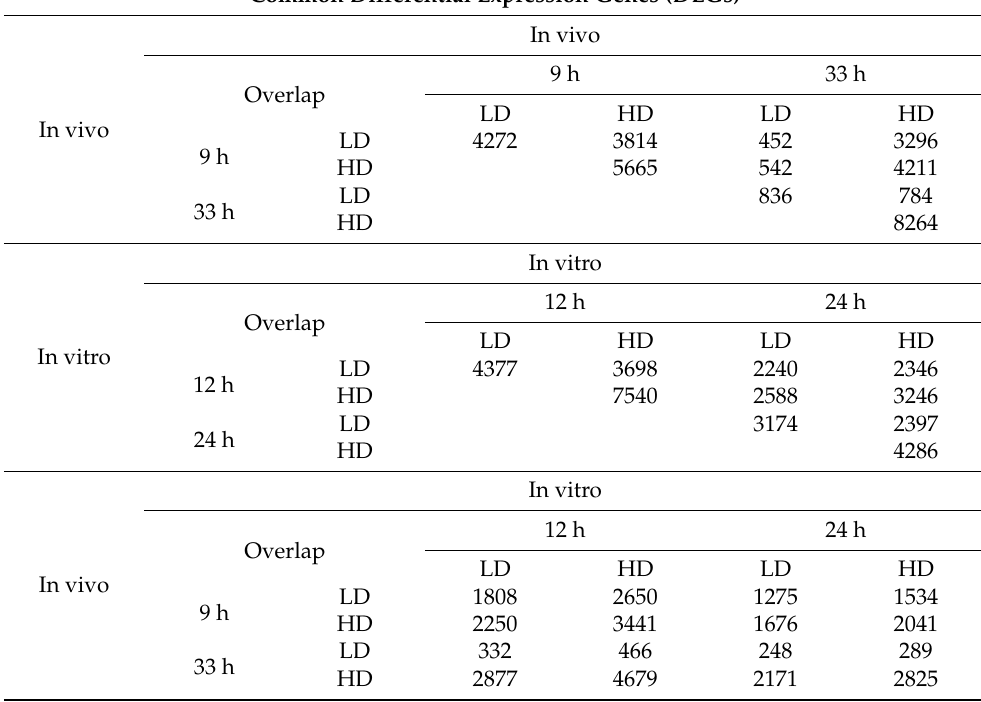
Table 1. Overlap of the number of significantly altered differential expression genes (q < 0.1) found in guinea pigs in vivo and in vitro data across all dose and time conditions. HD, high dose; LD, low dose. Common Differential Expression Genes